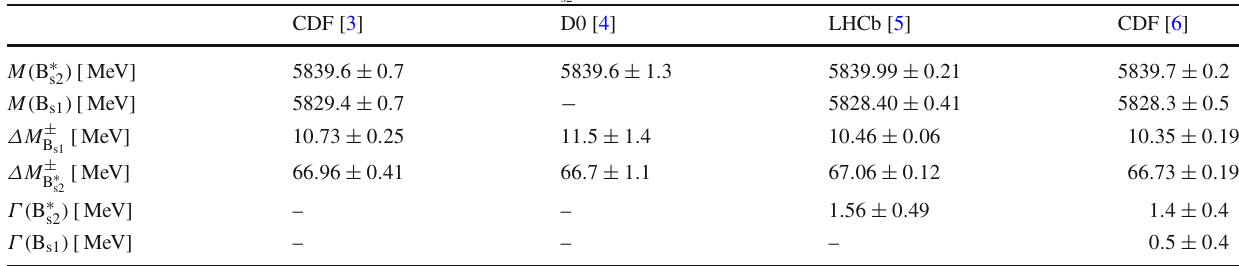
Table 1 Results on the masses, mass differences, and natural widths of ( ∗ ) the B mesons from previous measurements. The mass s1 , 2